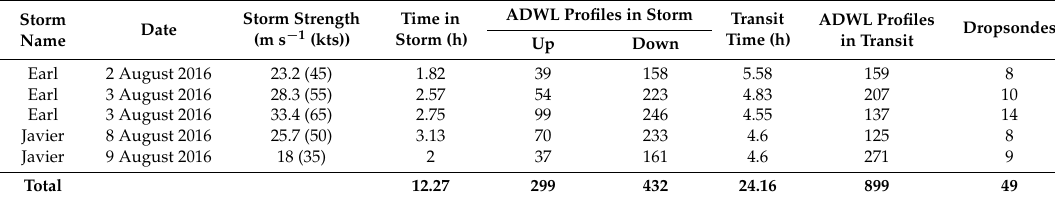
Figure 1. Location of airborne Doppler wind lidar (ADWL) wind profiles collected in the 2015 (dark blue) and 2016 (green and cyan) hurricane seasons. In the 2016 season, wind profiles were collected both during the transit (cyan) and in the TC environment (green). Location of dropsondes available for comparisons are also shown (red). Table 2. Overview of the 2016 Airborne Doppler Wind Lidar